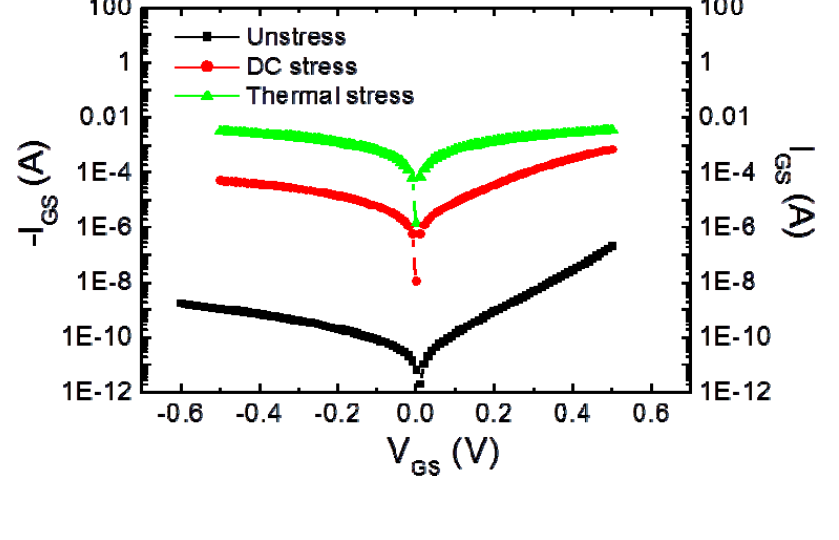
Figure 12. Gate I-V characteristics from MHEMTs before and after thermal or electrical